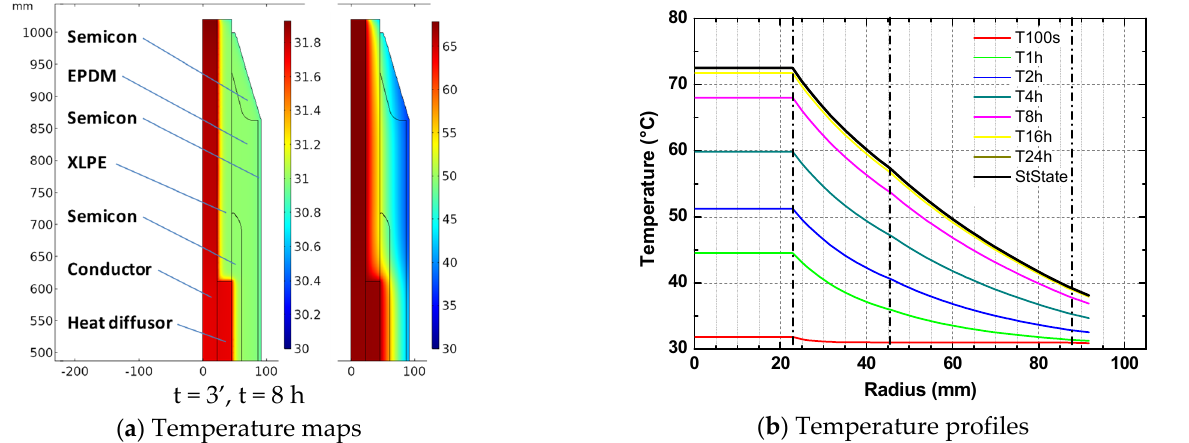
Figure 4. ( a ) Temperature distribution maps in the joint with XLPE/EPDM insulations at different times after applying the current of 1 kA in the conductor; ( b ) radial temperature distribution at different times and stationary solution, taken at z = 800 mm. Vertical lines indicate the boundaries of the insulators.